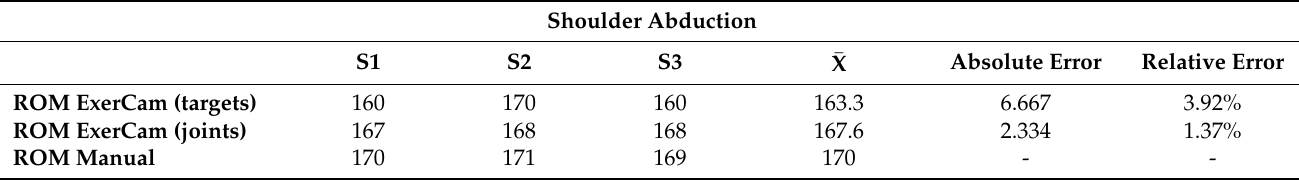
Table 3. Results of measurements in the shoulder abduction task.